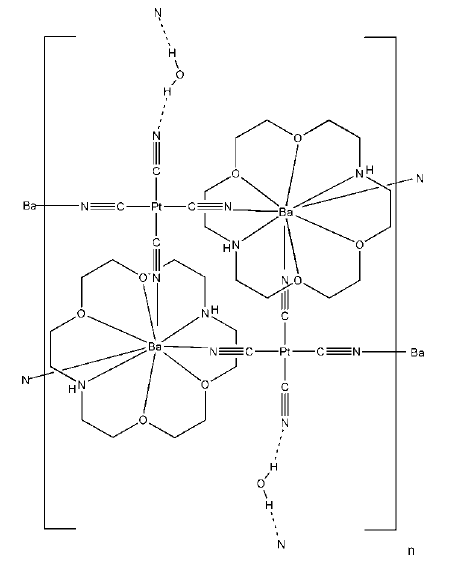
Hydrogen-bond geometry (A˚ , (cid:2)